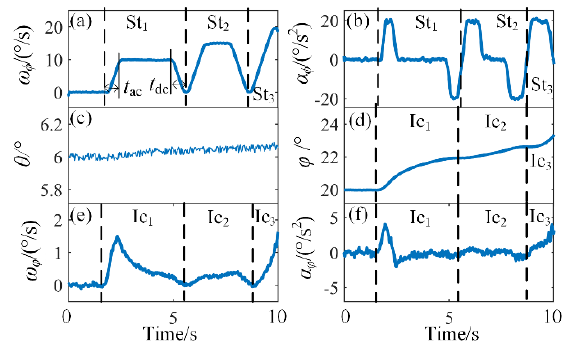
Figure 10 Relative results of attitude angle in the oblique incidence experiment: (a) angular velocity of roll ω ϕ over time; (b) angular acceleration of roll α ϕ over time; (c) the pitch θ over time; (d) the yaw φ over time; (e) angular velocity of yaw ω φ over time; (f) angular acceleration of yaw α φ over